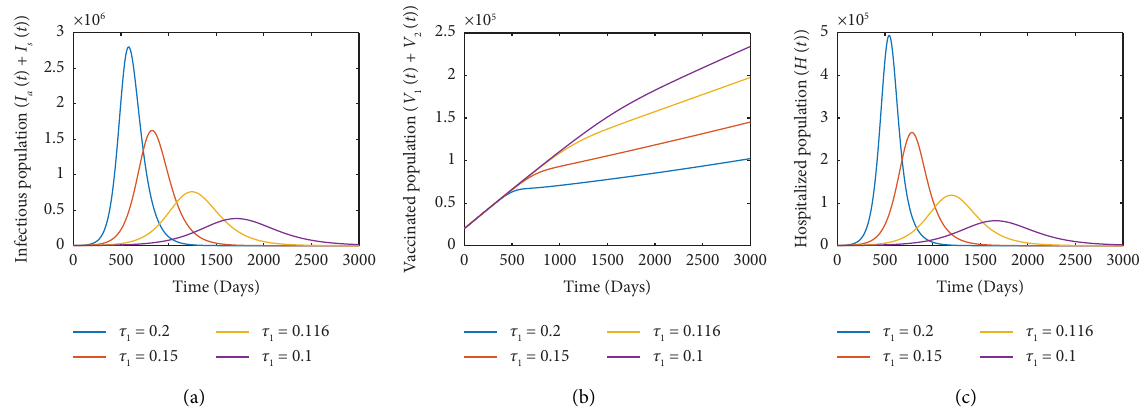
Figure 9: Te impact of the infectivity coefcient of asymptomatic population, τ vaccinated population, (b), and hospitalized population, (c) Other parameter values are as in Table